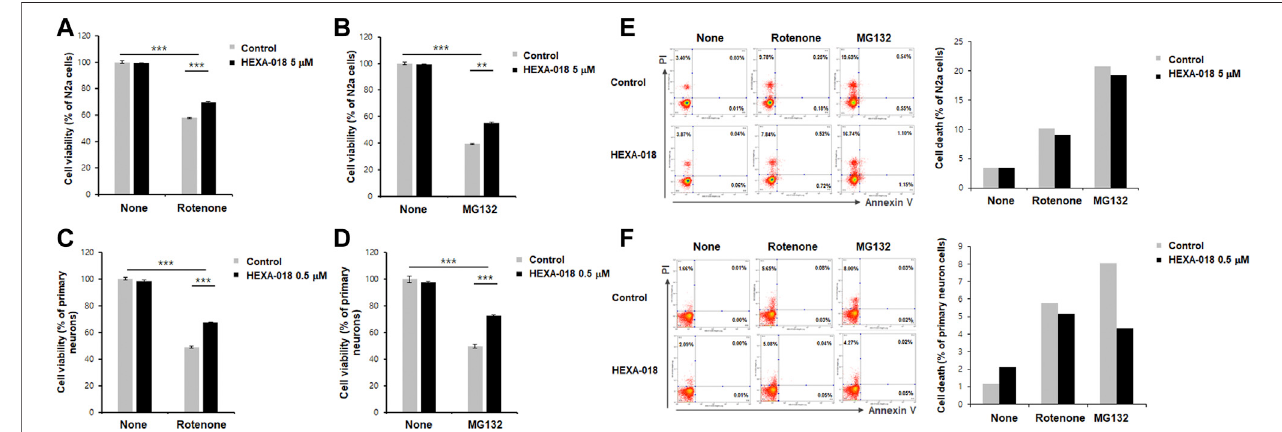
FIGURE 4 | HEXA-018 attenuates MG132-and rotenone-induced toxicity in neuronal cells. (A,B) N2a cells were pretreated with HEXA-018 (5 µM) for 30 min and subsequently treated with MG132 (5 μ M, (A) ) or rotenone (10 μ M, (B) ) for 24 h. CCK-8 analysis was performed thereafter. HEXA-018 signi fi cantly reduced MG132-or rotenone-induced neuronal toxicity in N2a cells. Data are presented as the mean ± SD of 3 independent experiments. ** p < 0.005; *** p < 0.001 (one-way ANOVA with Tukey ’ smultiplecomparisontest). (C,D) PrimaryneuronswerepretreatedwithHEXA-018(0.5 µM)for30 minandsubsequentlytreatedwithMG132(5 μ M, (C) )or rotenone (10 μ M, (D) ) for 24 h. MG132-or rotenone-induced neuronal toxicity was also reduced by HEXA-018 treatment in primary neurons. CCK-8 analysis was performed thereafter. 5 µM or 0.5 µM were the maximum non-cytotoxic concentrations of HEXA-018 in N2a cells and primary neurons, respectively. HEXA-018 concentration was then assessed after 24 h treatment using the each highest concentrations showing no toxicity in N2a cells and primary neurons. Data are presented as the mean ± SD of 3 independent experiments. *** p < 0.001 (one-way ANOVA with Tukey ’ s multiple comparison test). (E,F) N2a cells and primary neurons were pretreated with HEXA-018 (5/0.5 µM) for 30 min and subsequently treated withMG132 (5 µM) orrotenone(10 µM) for 24 h. FACS analysiswasadditional performed to assess cell viability after HEXA-018 treatment against neurotoxic drugs (10,000 cells per each condition). Representative scatter plots show that annexin V − /PI + (upper left quadrant,necrosis) and annexin V + /PI + (upperright quadrant, lateapoptosis/necrosis) weresigni fi cantlyincreasedby MG132 orrotenone,but annexin V + /PI − (lower right quadrant, early apoptosis) was not signi fi cantly changed in N2a cells and primary neurons. The proportion of cells residing in each quadrant is represented as a percentage. The percentage of cell death (apoptosis and necrosis) in the fl ow cytometric analysis is shown ( right